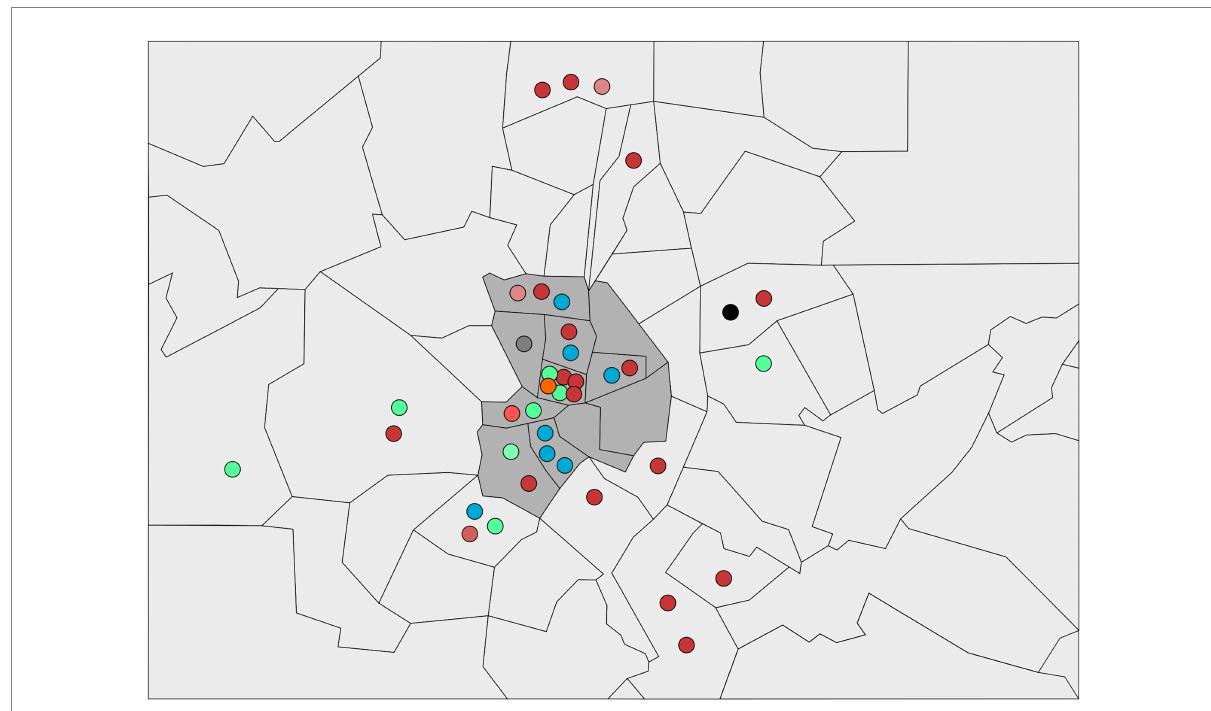
FIGURE 5 Schematic representation of the districts of Madrid where LGV cases were identified. The different circles correspond to the L2b variants detected in the study. Each color represents a different variant. The black circle corresponds to the L2b variant reported in Netherlands; red-tone circles correspond to L2b- ompA L2 variants; blue-tone circles correspond to L2bV1 variants and green-tone circles correspond to L2bV7 variants. The central district is identified in grey